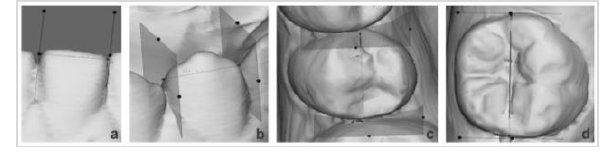
Figure 2. Measurements of teeth on 3D images